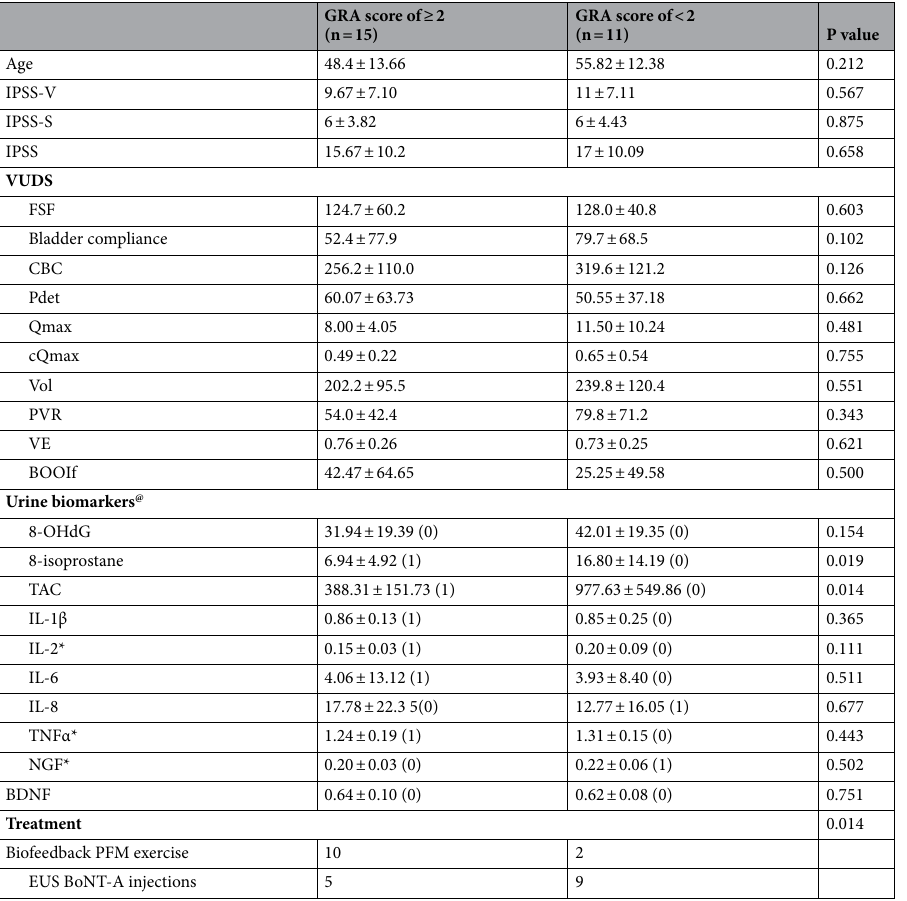
Table 4. Pretreatment clinical characteristics and urine biomarker levels of patients with DV who presented with different treatment outcomes. DV Dysfunctional voiding, GRA Global response assessment,